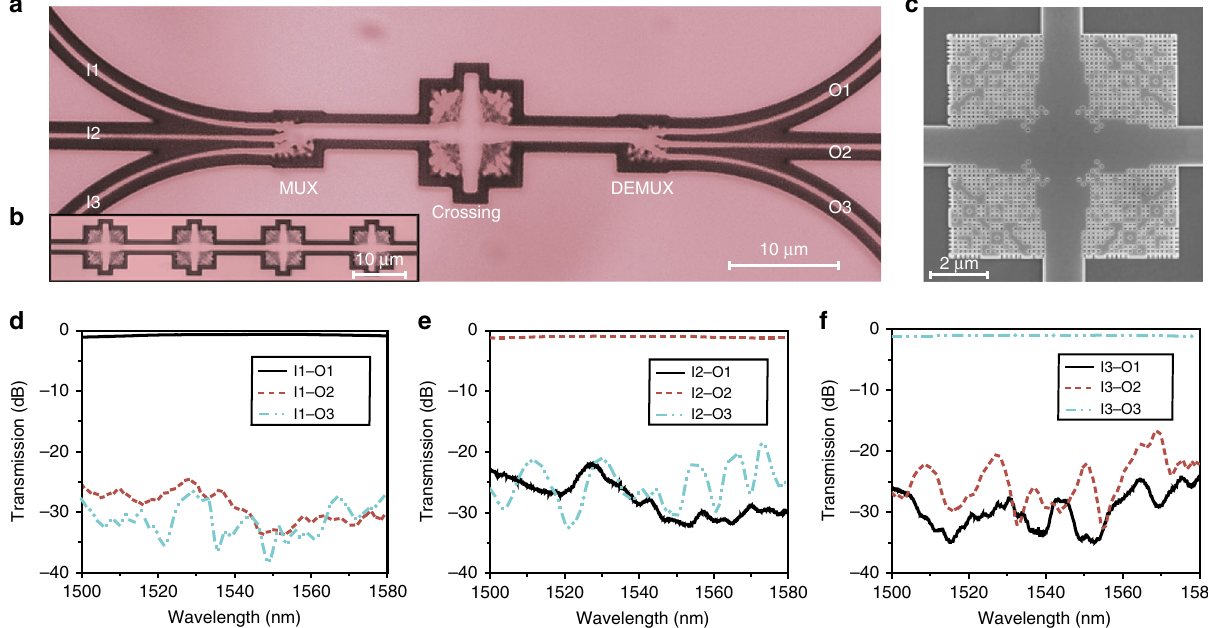
Fig. 4 Fabrication and experimental results of the three-mode crossing. a The top-view microscope image of the mode-division multiplexing (MDM) circuit consisting of a multiplexer, a crossing, and a demultiplexer. b The microscope image of the four-cascaded crossing. c The scanning electron microscope image of the fabricated crossing. d ‒ f The measured transmission spectra for the MDM